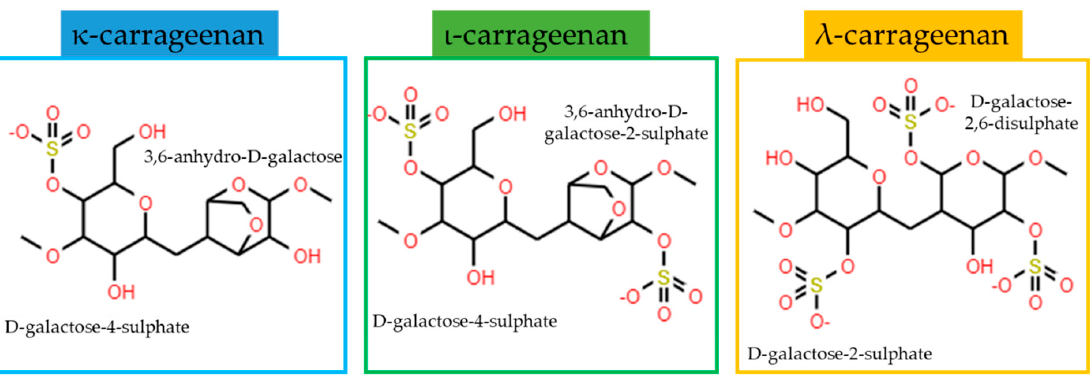
Figure 5. Chemical structures of the most industrially relevant carrageenans.